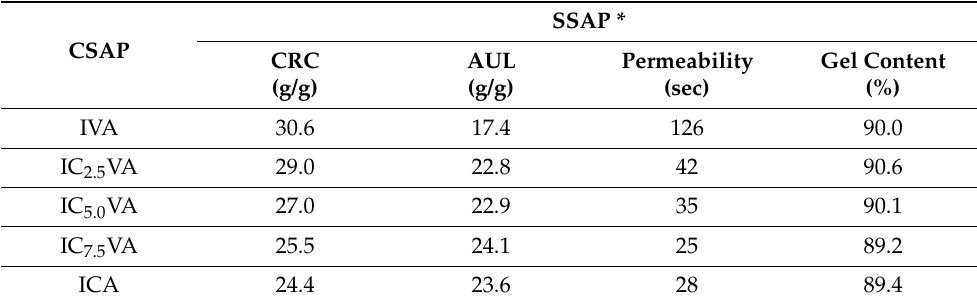
Table 4. The absorption properties of the surface-crosslinked SAP (SSAP) according to the compo- sition of monomer.